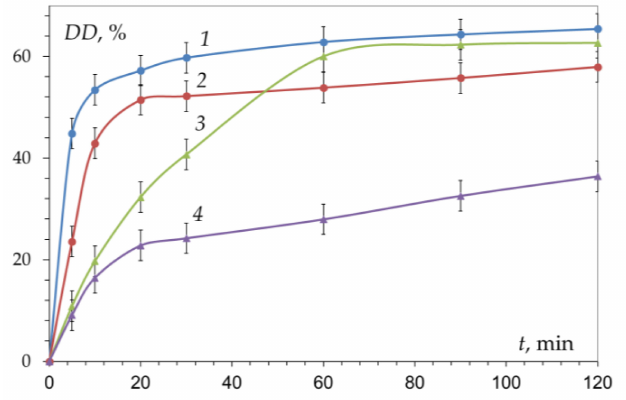
Figure 6. Kinetic curves of chitin deacetylation: 1—initial dry; 2—initial wet; 3—dry reprecipitated from solution in HCl; and 4—wet reprecipitated from HCl solution. Conditions: 50% NaOH, 100 ◦ C. Original figure.